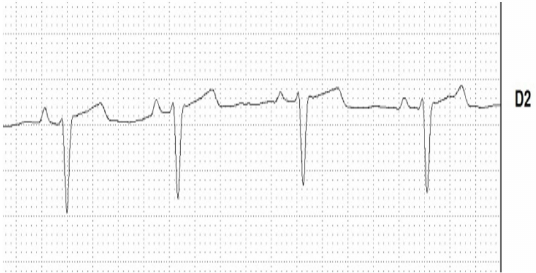
Figure 2. Electrocardiogram examination showing deep “S” waves and sinus rhythm. DII; N; 50mm/S.